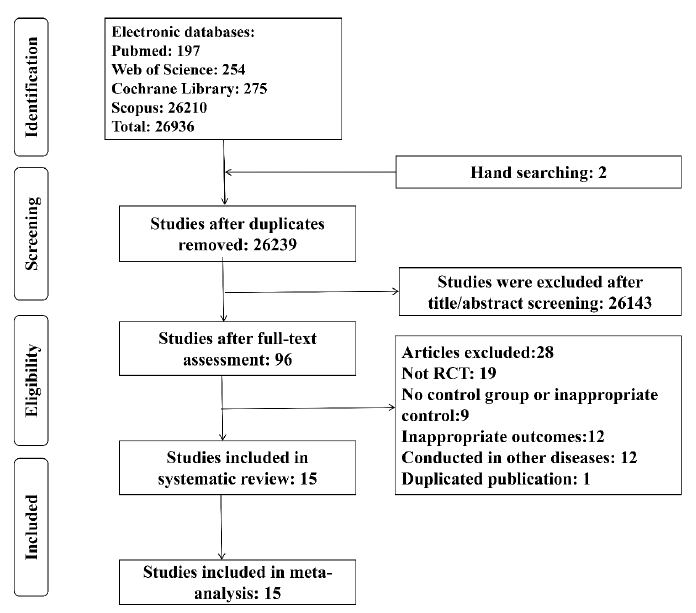
Figure 1. Flow diagram of the present meta-analysis.